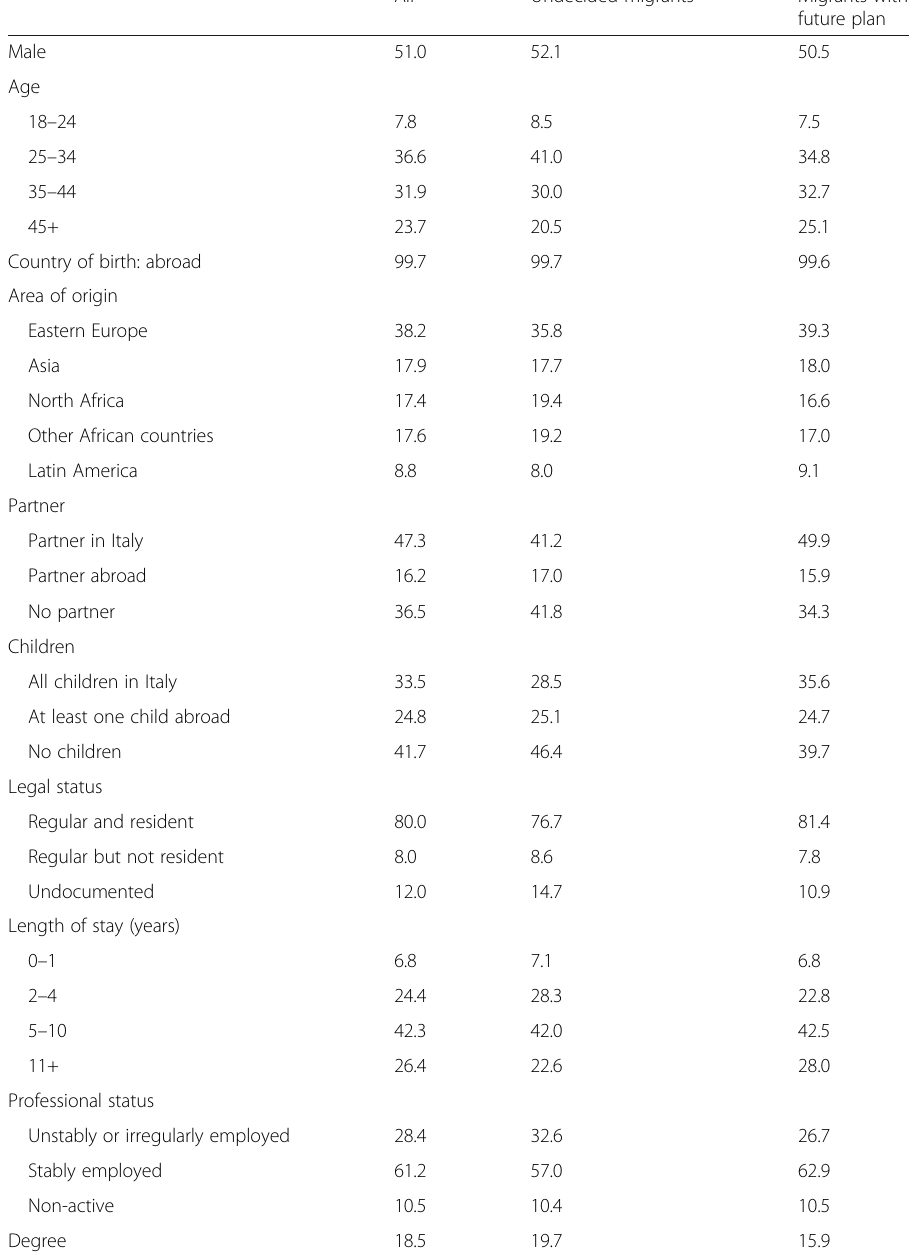
Table 1 Descriptive statistics of migrants living in Italy according to future plan (percent), 2008 – 2009